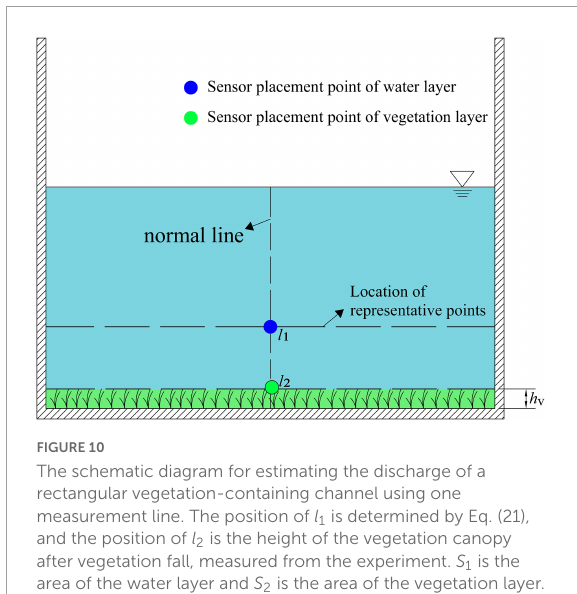
FIGURE10 The schematic diagram for estimating the discharge of a rectangular vegetation-containing channel using one measurement line. The position of l 1 is determined by Eq. (21), and the position of l 2 is the height of the vegetation canopy after vegetation fall, measured from the experiment. S 1 is the area of the water layer and S 2 is the area of the vegetation layer.